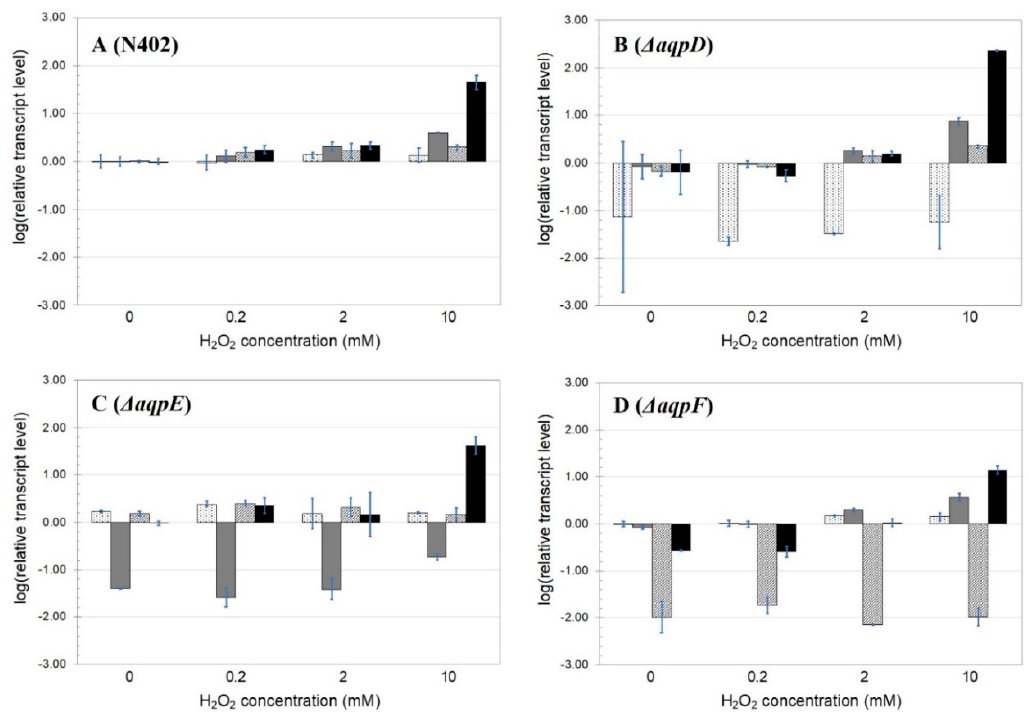
Figure 7. Expression analysis of A. niger AQPs knock − out strains under varying concentrations of hydrogen peroxide . Results of the strain N402 ( A ), Δ aqpD ( B ), Δ aqpE ( C ), and Δ aqpF ( D ). Samples were taken one hour after the addition of 0 − 10 mM hydrogen peroxide. The expression analyses were performed by RT − qPCR with primers speci fi c for aqpD (white background fi lled with dots), aqpE (gray bar), aqpF (white background fi lled with stripes), and goxC (black). goxC gene expression was used as a proxy for hydrogen peroxide uptake. The data presented is the mean of two biological replicates using a logarithmic scale (log10).